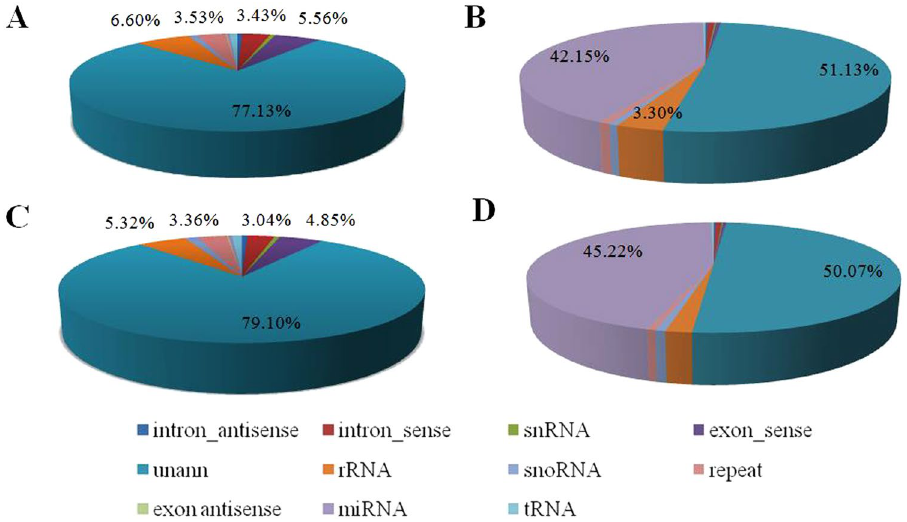
Figure 2. Composition of small RNA classes of the Solexa sequencing results. ( A ) Composition of unique sequences in the non-prolific Tibetan goat (TBG) library. ( B ) Composition of clean reads in the non-prolific TBG library. ( C ) Composition of unique sequences in the prolific Jintang black goat (JTB) library. ( D ) Composition of clean reads in the prolific JTB library.